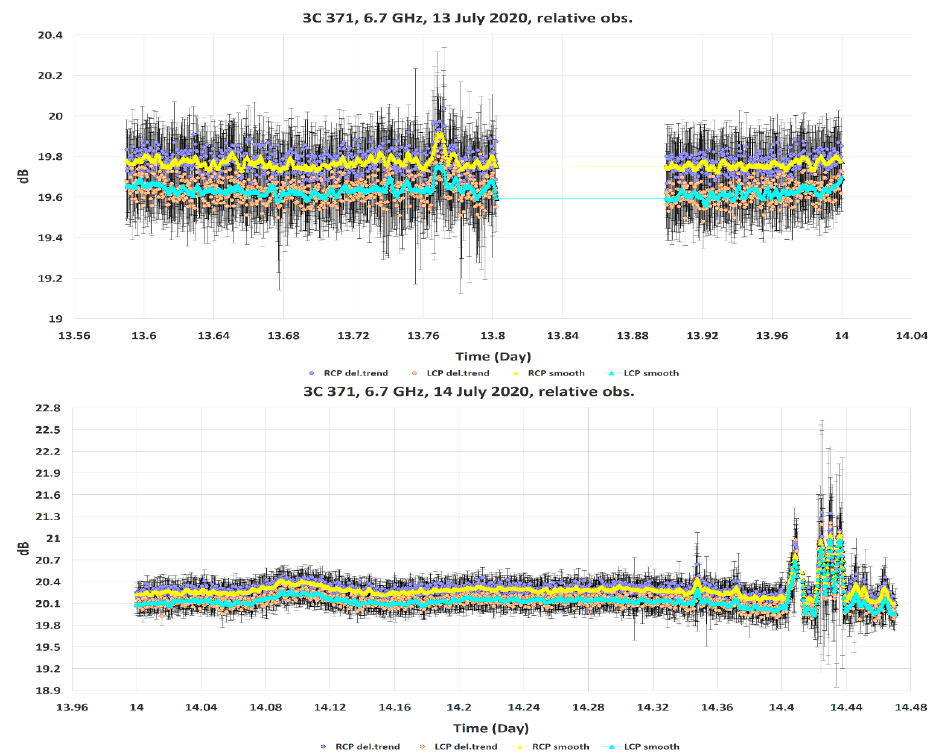
Figure 5. Plots of “relative” observations of 3C 371, obtained on 13 July ( top ) and 14 July ( bottom ) 2020 at a frequency 6.7 GHz. Solid lines-smoothing using the Savitzky–Golay filter with a half-width 10 points of the smoothing window, a polynomial degree is 2, the number of passes 3. As can see in the plots, the intensity variations are almost within the error limits, except for individual episodic bursts. At the end of the observation session on 14 July, high-amplitude impulse bursts (possibly interference) are visible.